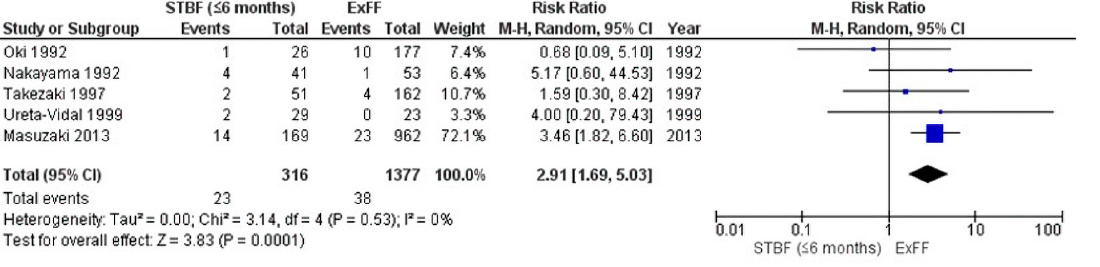
Figure 3. Forest plot of the risk ratios of HTLV-1 MTCT in the STBF ≤ 6 months group compared with that of the ExFF group. Comparing STBF ≤ 6 months and ExFF showed that STBF ≤ 6 months was associated with an approximately 3-fold higher risk of MTCT than that of ExFF (pooled RR: 2.91, 95% CI: 1.69–5.03). Abbreviations: STBF, short-term breastfeeding; ExFF, exclusive formula feeding; M–H, Mantel–Haenszel; CI, confidence interval; RR, risk ratio; MTCT, mother-to-child transmission; events, number of cases with mother-to-child transmission; total, number of children born to carrier mothers; weight, influence of studies on overall meta-analysis. The figure is reproduced from Miyazawa et al.